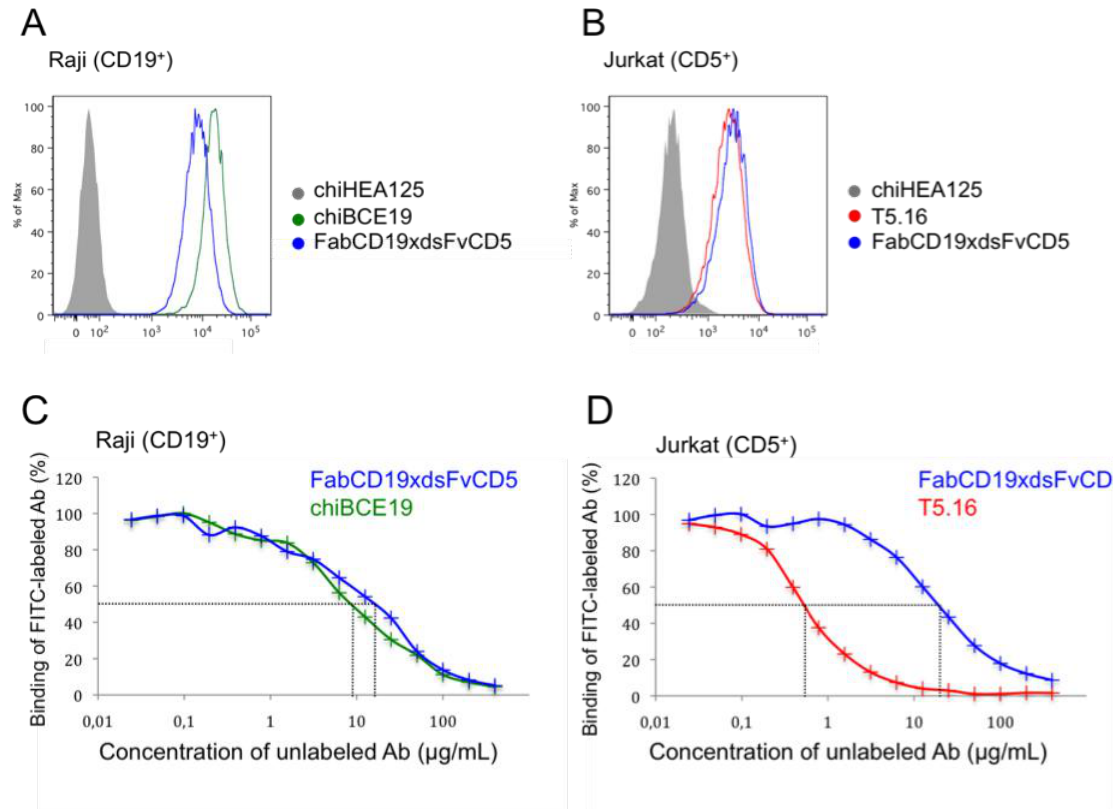
Figure 3. Immunoreactivity and avidity of bsAb. ( A and B ) Binding of bsAb FabCD19xCD5 and its parental antibodies to lymphoma lines Raji and Jurkat was measured by flow cytometry. As a negative control chiHEA125 was used, which is a chimeric anti-EpCAM antibody of human IgG1 isotype and does not react with lymphoma cells (grey histograms). ( C and D ) Flow cytometric binding competition assay comparing the binding strength of bsAb versus the parental mAb. The IC50 values are indicated by a dotted